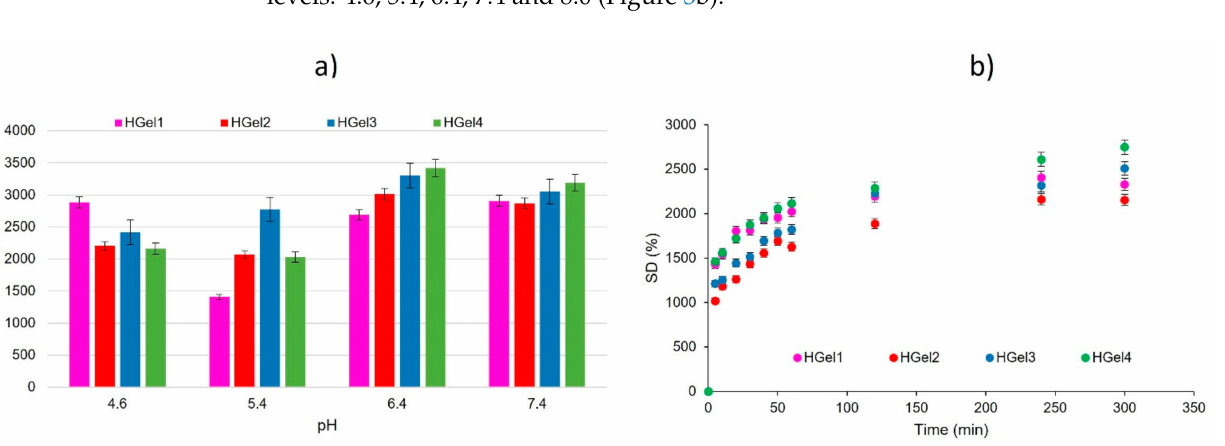
Figure 3. ( a ) Variation of the degree of swelling over time of hydrogels, at pH 7.4. ( b ) Variation of ESD of hydrogel in relation to the change of environmental pH. Means ± SD, n =